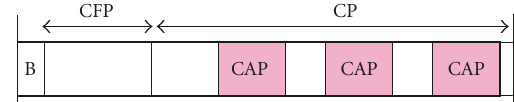
Figure 3: CFP, CP, and CAPs in the